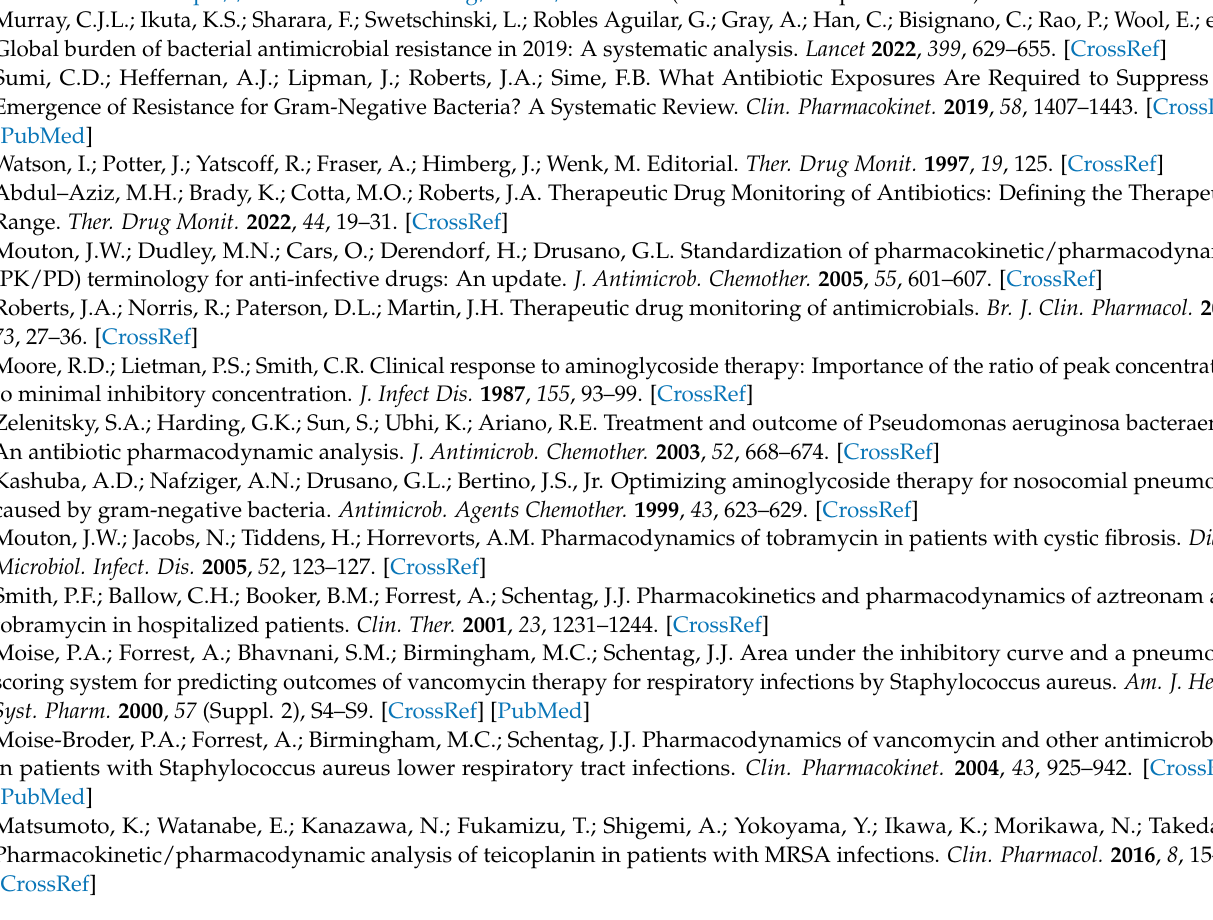
apy; Table S3: Study characteristics of clinical case studies where TDM has been used to guide carbapenem